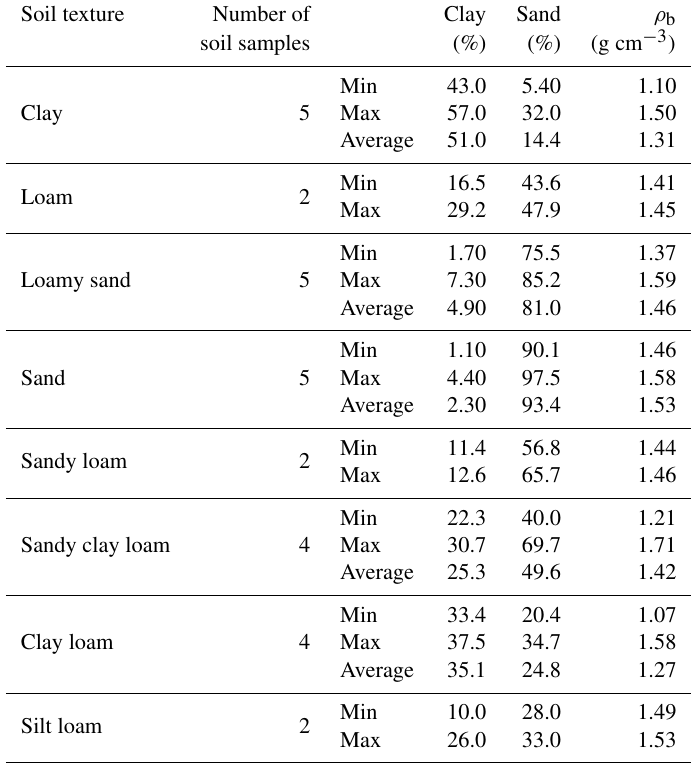
Table 5. Basic soil properties of 29 samples for the model